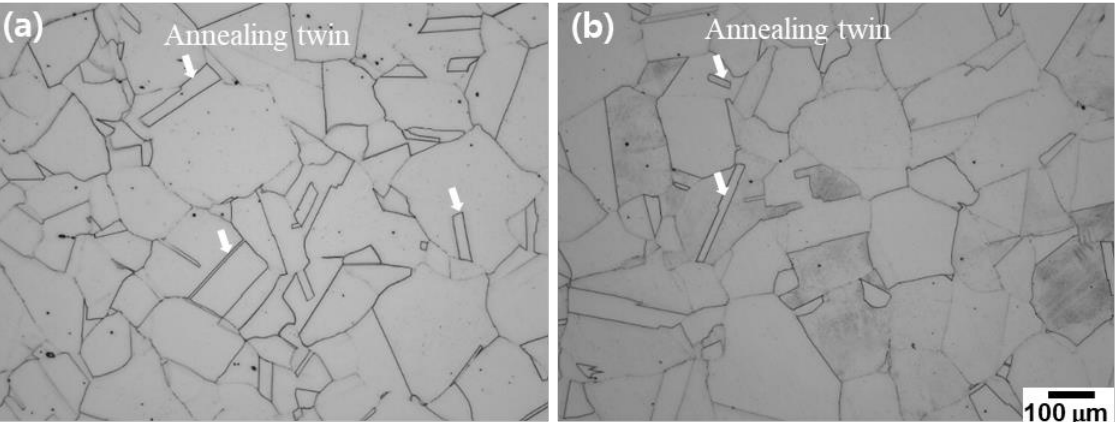
Figure 3. Optical micrograph showing the microstructures after ( a ) annealing heat treatments and ( b ) aging heat